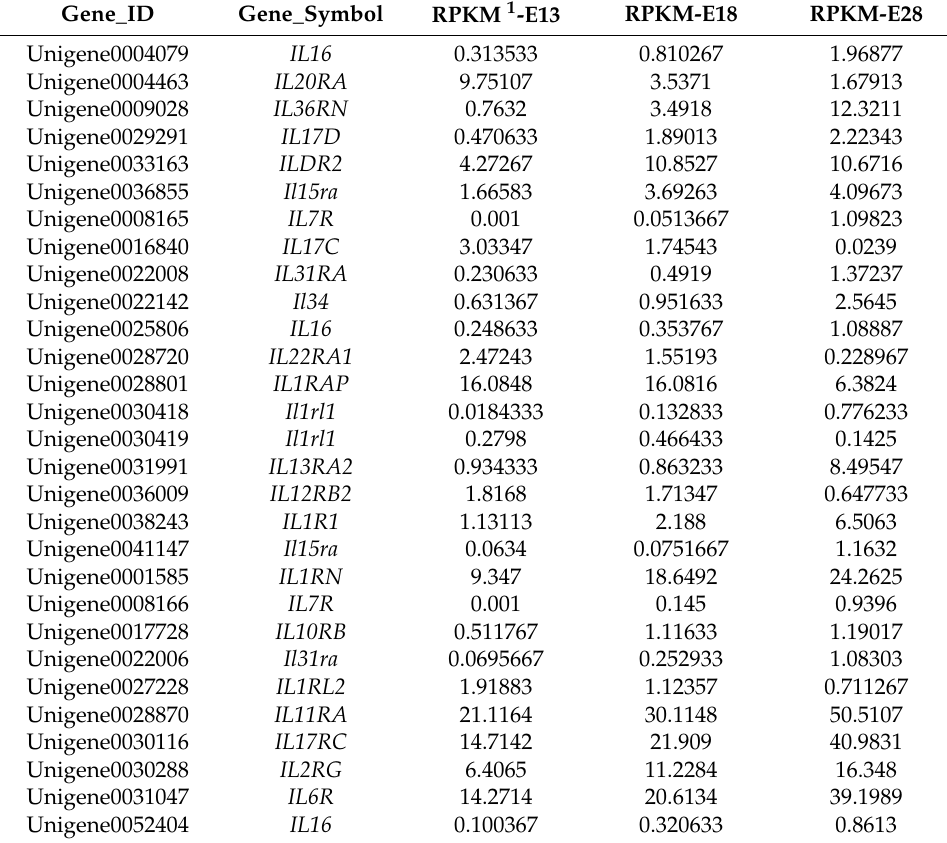
Table 2. List of differentially expressed genes (DEGs) belonging to interleukins (ILs) family expressed in E13, E18, and E28, which were detectable in the feather follicles of goose. Gene_ID Gene_Symbol RPKM 1